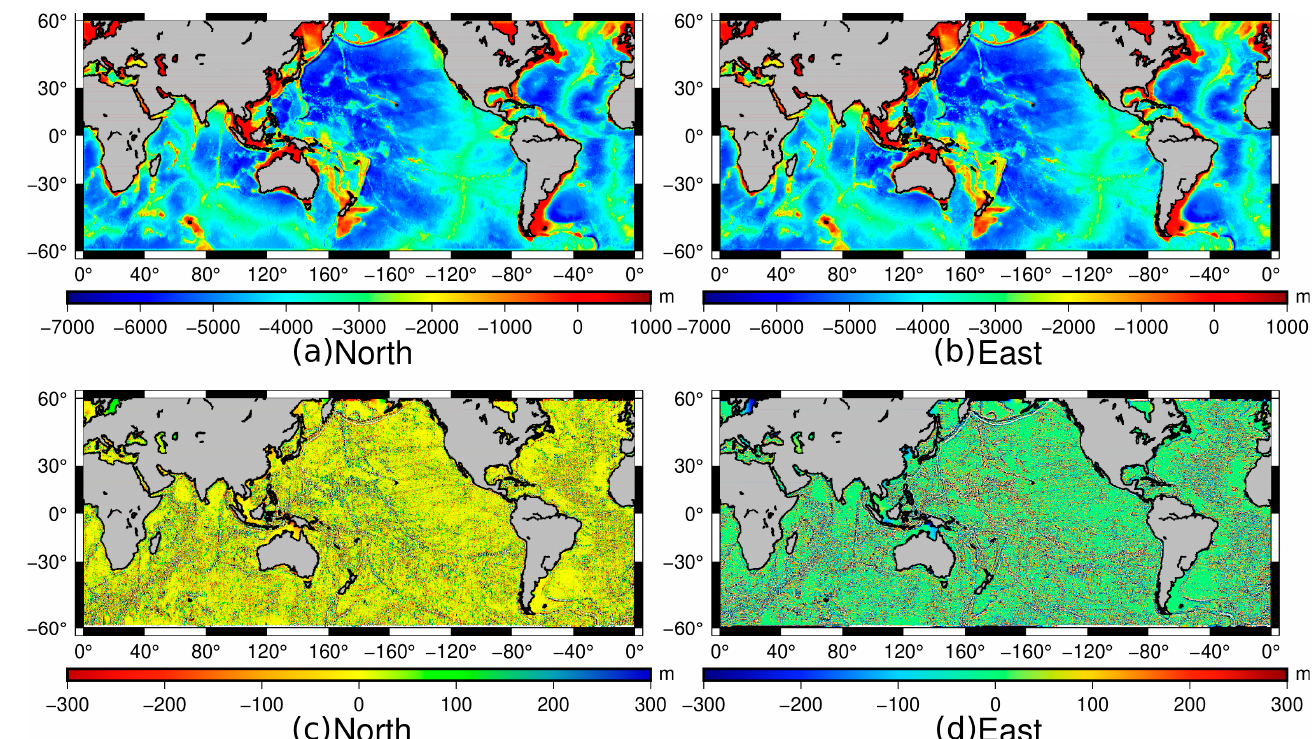
Figure 6. ( a ) The spatial distribution of DOV_N2021BAT; ( b ) The spatial distribution of DOV_E2021BAT; ( c ) The differences between DOV_N2021BAT and shipborne depths; ( d ) The dif- ferences between DOV_E2021BAT and shipborne depths. Table 1. Precision statistics of bathymetry inversion results by